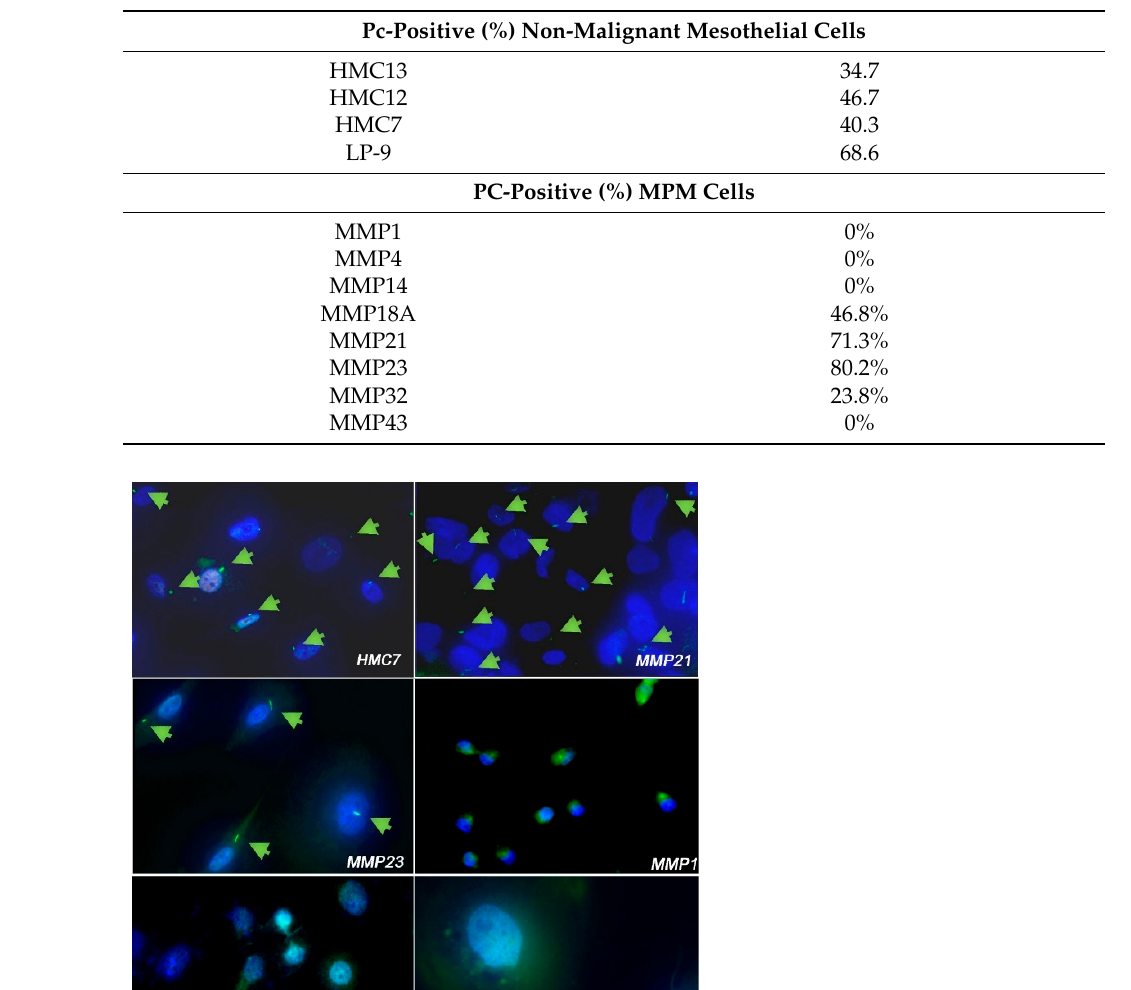
Table 2. Expression of PC in non-tumoral mesothelial and in mesothelioma cell lines. PC expression was analyzed by IF with Arl13b antibody.